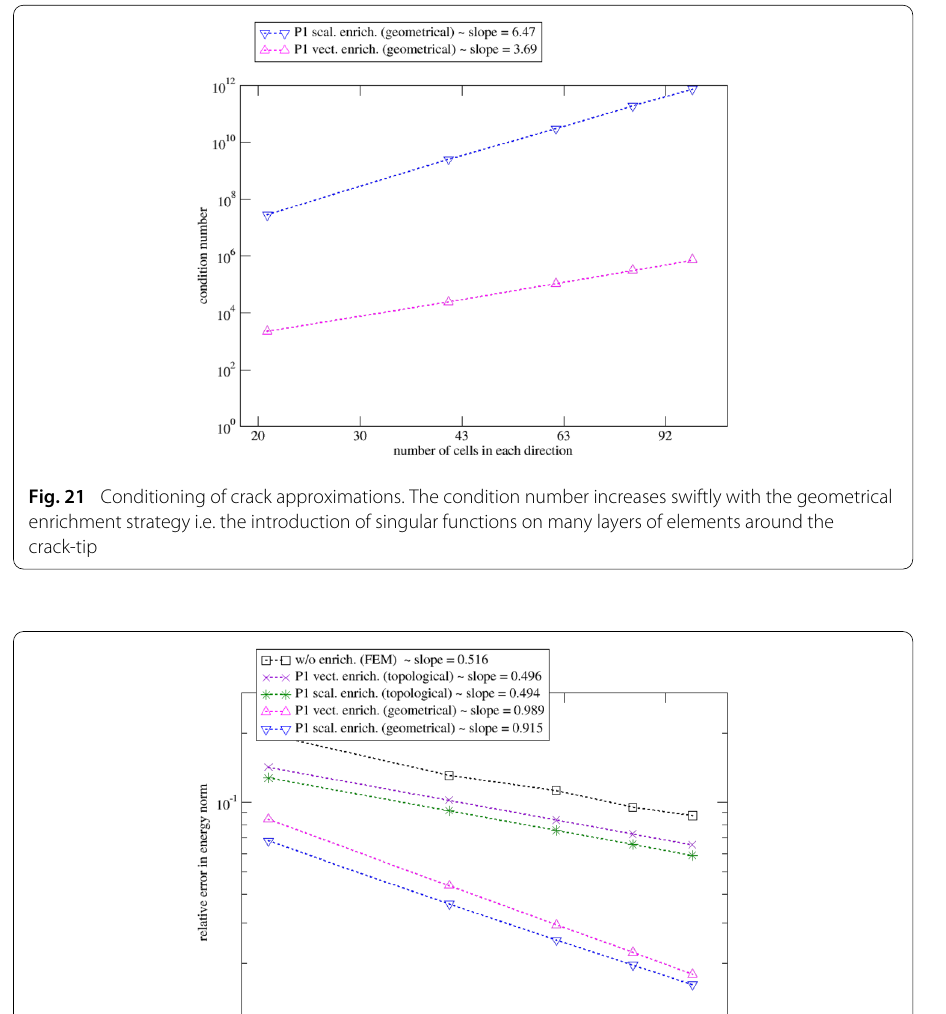
are applied (Fig. 24), similarly to the case of the horizontal crack. We consider the same regular meshes as above which are not oriented accordingly to the crack surface here.